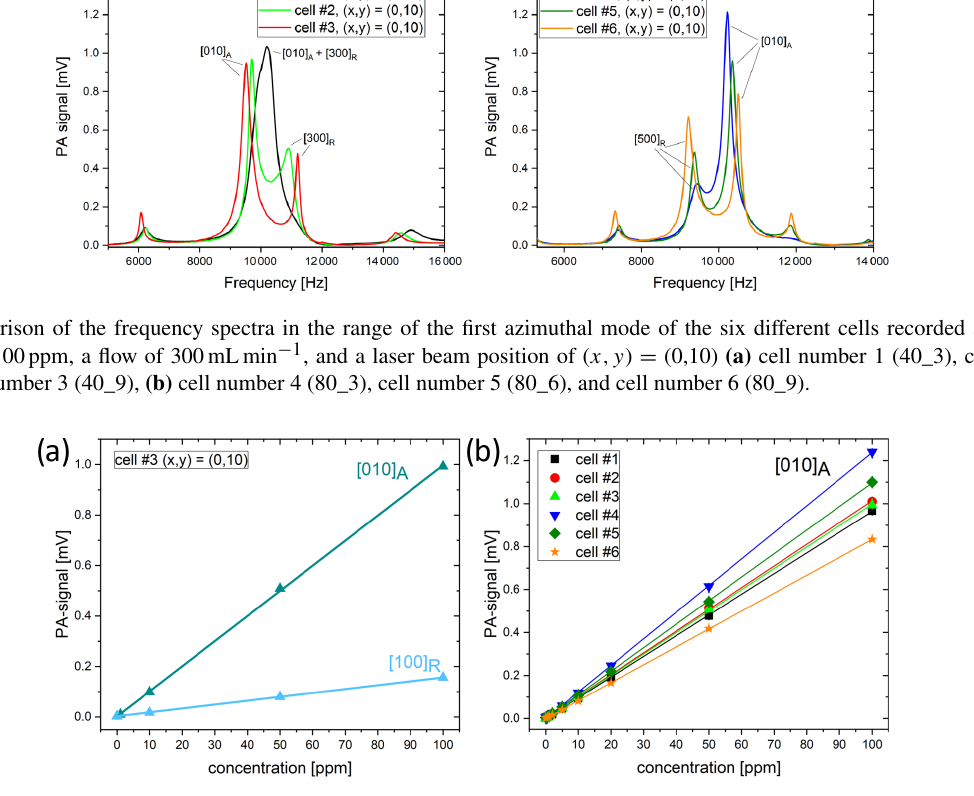
Figure 4. (a) PA signals obtained for methane concentrations of 1, 10, 50, and 100ppm for the first azimuthal mode in the absorption cylinder and the first longitudinal mode in the resonance cylinder in cell number 3. The signals are significantly higher in first azimuthal mode. (b) PA signals obtained for methane concentrations of 1, 5, 10, 20, 50, and 100ppm for all cells. The highest signals were obtained for cell number 4. All measurements were performed using N 2 as carrier gas and at a gas flow of 300mLmin − 1 at a laser beam position of ( x,y ) =